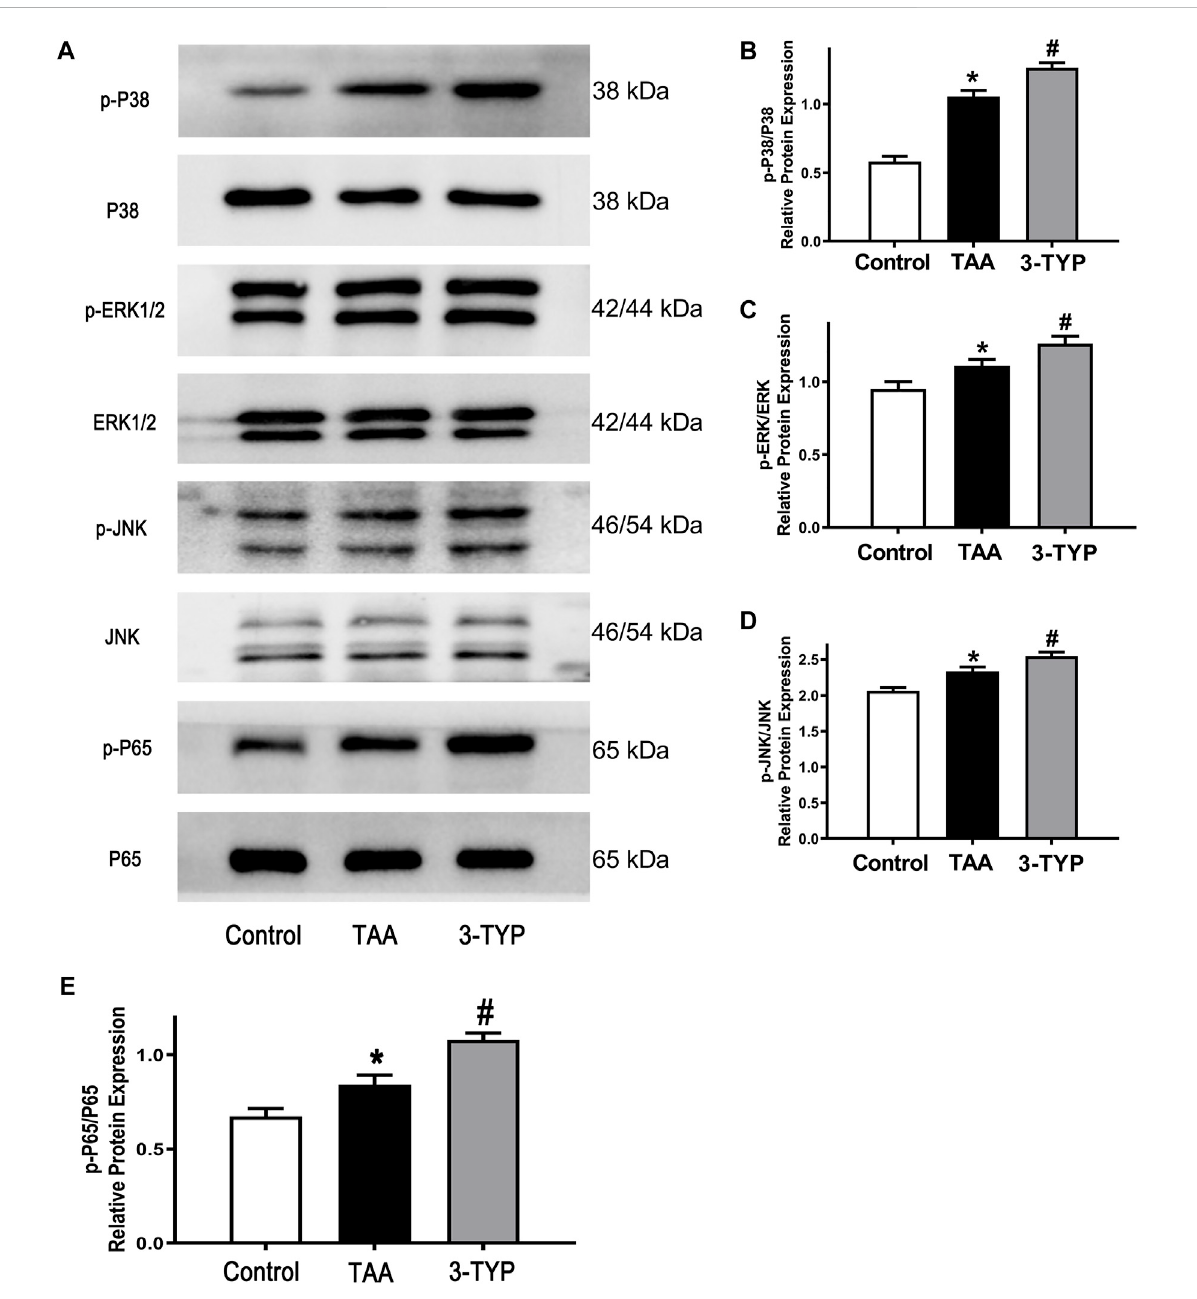
Effectof3-TYPonactivationofMAPKandNF- κ Bpathwaysineachgroup, n =10pergroup. (A) Theexpressionsofp-P38,P38,p-ERK1/2,ERK1/ 2, p-JNK, and JNK in liver tissues were detected by western blotting. (B) The quantitative values of p-P38/P38. (C) The quantitative values of p-ERK/ ERK. (D) The quantitative blots of p-JNK/JNK. (E) The quantitative blots of p-P65/P65. * p < 0.05, vs . the control group. # p < 0.05, vs . the TAA